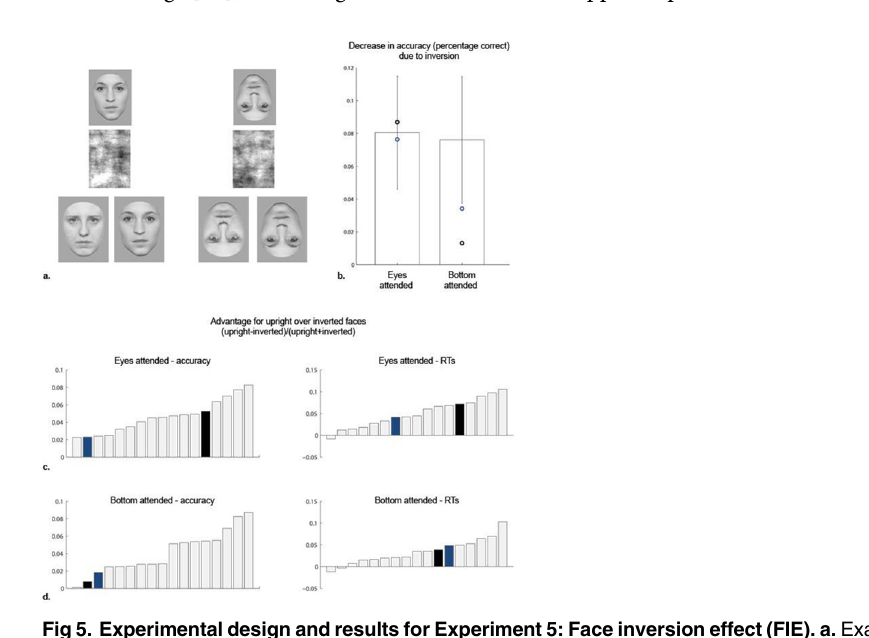
Fig 5. Experimental design and results for Experiment 5: Face inversion effect (FIE). a. Examples of stimuli presented on a given trial (see Methods). b. Controls ’ average decrease in accuracy related to inversion as a function of face part attended. Individual subjects ’ accuracy and RT advantage for upright over inverted face matching when attending c. the eyes and d. the mouth. Note that SMs ’ performance decreases (SM1: black; SM2: blue) were not significantly different from those observed for